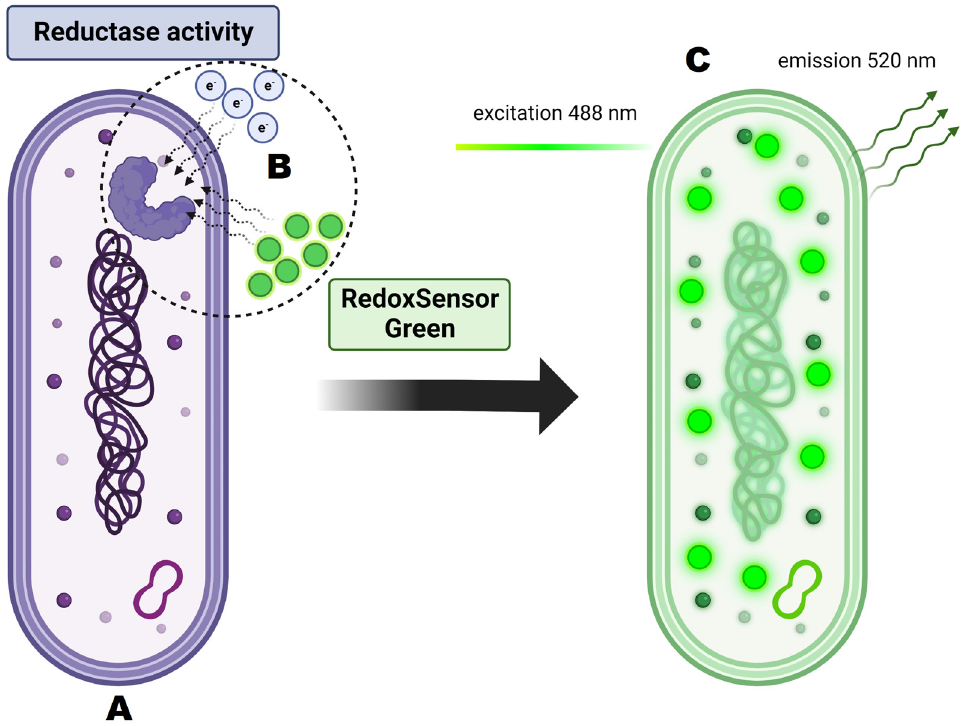
Figure 10. Principles of RedoxSensor TM Green staining and its activity on the cellular level. ( A ) Analyzed cell is dyed with RedoxSensor TM Green. ( B ) Dye molecules permeate the cell membrane and interact with reductases. Reductase activity reflects changes in electron transport chain function and in vitality. ( C ) After excitation at 488 nm the dye emits green-fluorescent signal at 520 nm.